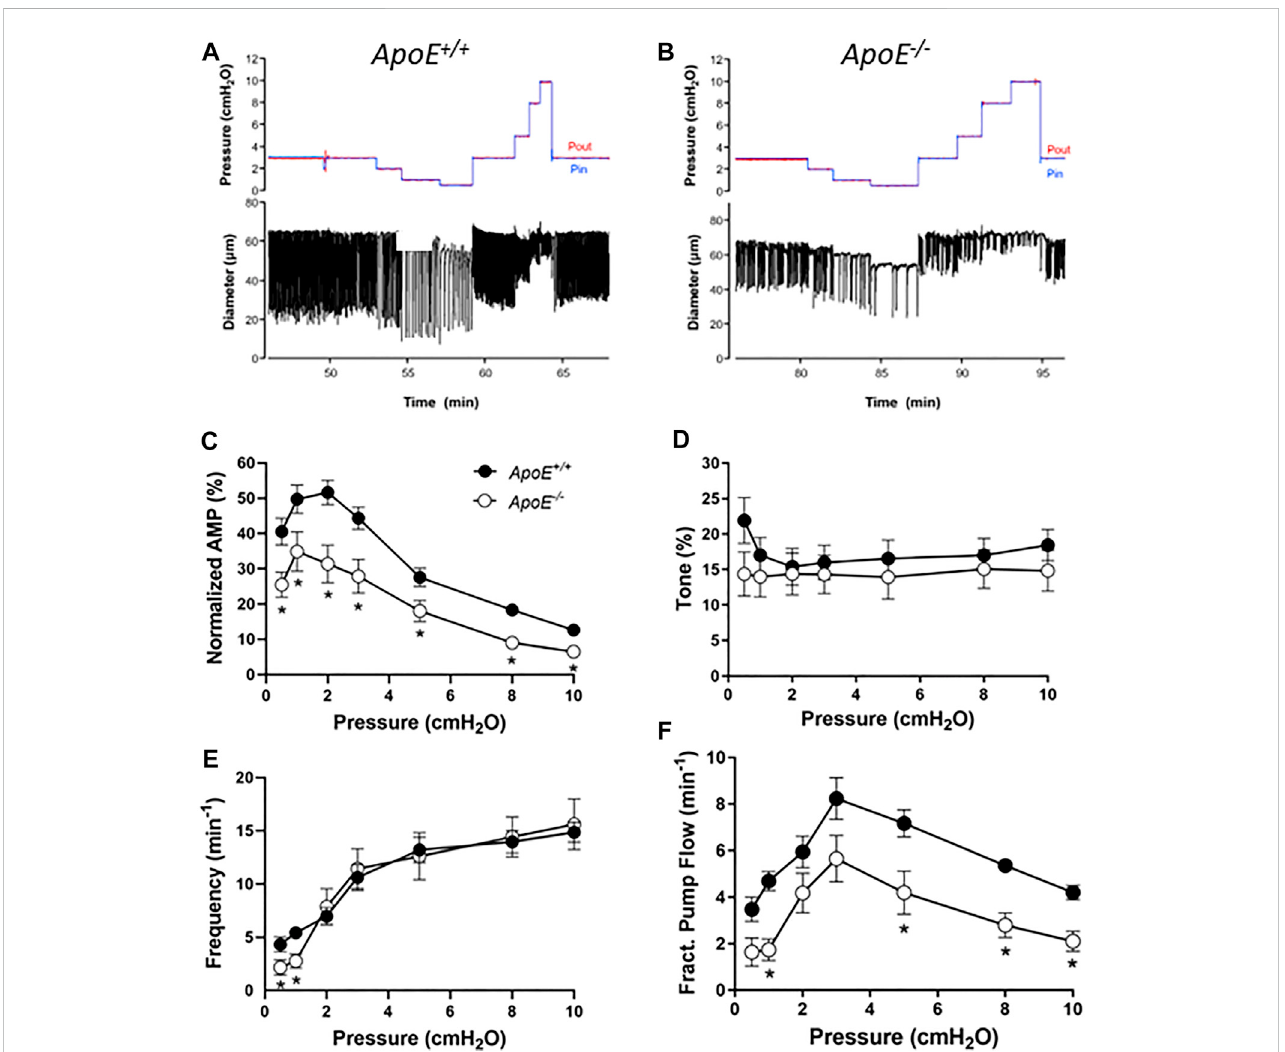
FIGURE 1 Contractileparametersof ApoE +/+ and ApoE − / − popliteallymphaticvessels.Contractilestrengthwasconsistentlyreducedatallpressuresbetween.5and 10 cmH 2 0 in ApoE − / − vessels. (A) Recording of spontaneous contractions from an ApoE +/+ popliteal lymphatic vessel at different levels of luminal pressure. Each downward de fl ection in diameter represents a single, twitch contraction. (B) Recording of spontaneous contractions from an ApoE − / − lymphatic in response to the same protocol. Note the relatively reduced contraction amplitude at all pressures and reduced contraction frequency at the lowest pressure. (C) Summary data for normalized amplitude; changes in ejection fraction (not shown) were similar. (D) Summary data for tone, which was signi fi cantly differentatonly thelowest pressure(the least reliable measurement oftone). (E) Summary data for frequency,which was signi fi cantly differentat thetwolowestpressures. (F) Fractionalpump fl owwassigni fi cantlyreducedin ApoE − / − vesselsatabouthalfthepressures.Statisticaldifferenceswereassessed via mixed-effects model ANOVAs with Geisser-Greenhouse correction (allowing for missing values or unequal groups) with Fisher ’ s LSD multiple comparisons post hoc